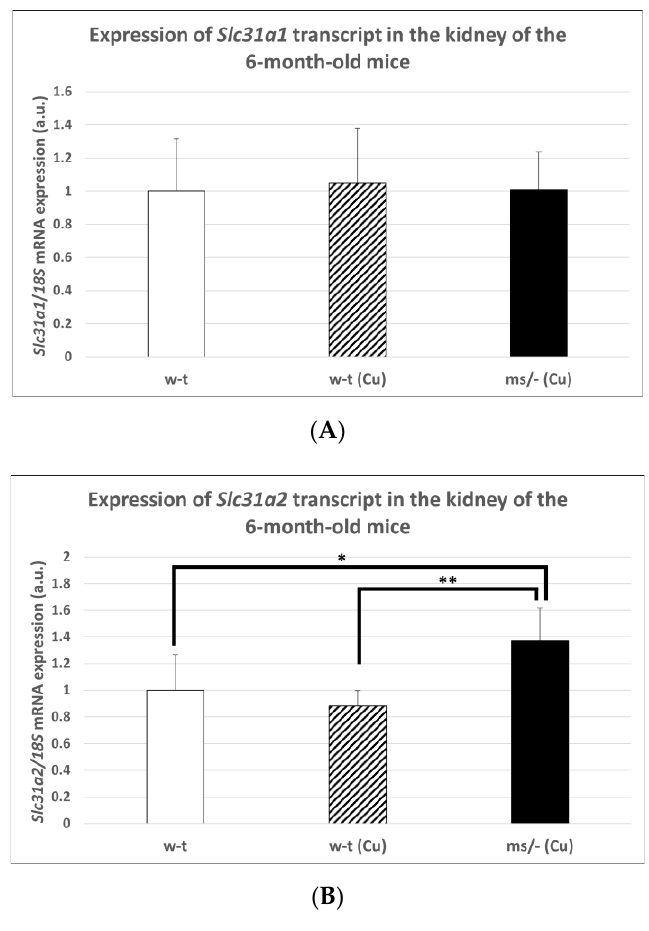
Figure 7. Expression of Slc31a1 ( A ) and Slc31a2 ( B ) genes in the kidney of adult (6-month-old), w-t and mosaic mutant mice. The histograms display mRNA levels in arbitrary units (means ± S.D., n = 5, (* p < 0.05, ** p < 0.01).